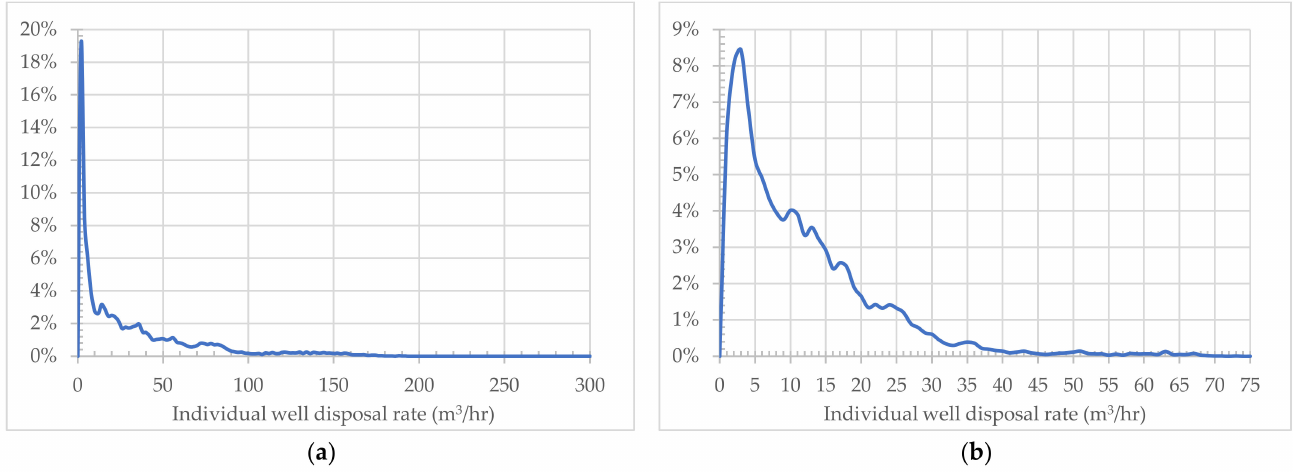
Figure A15. Historical per-well water injection rate ( X -axis) frequency ( Y -axis) distributions (January 1962–December 2022) in ( a ) the Ellerslie Formation; ( b ) the Taber